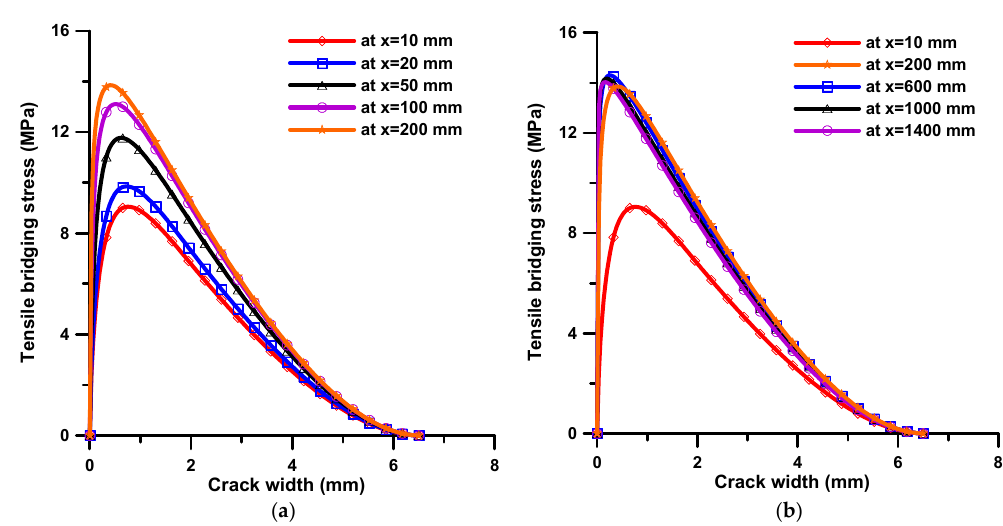
Figure 4. Simulated fiber bridging curves according to the flow distance; ( a ) up to 200 mm flow distance; and ( b ) for overall flow distance.